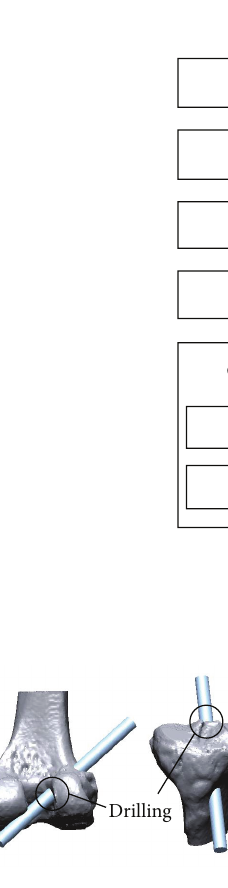
Figure 6: Construction of the tunnel and ACL graft.